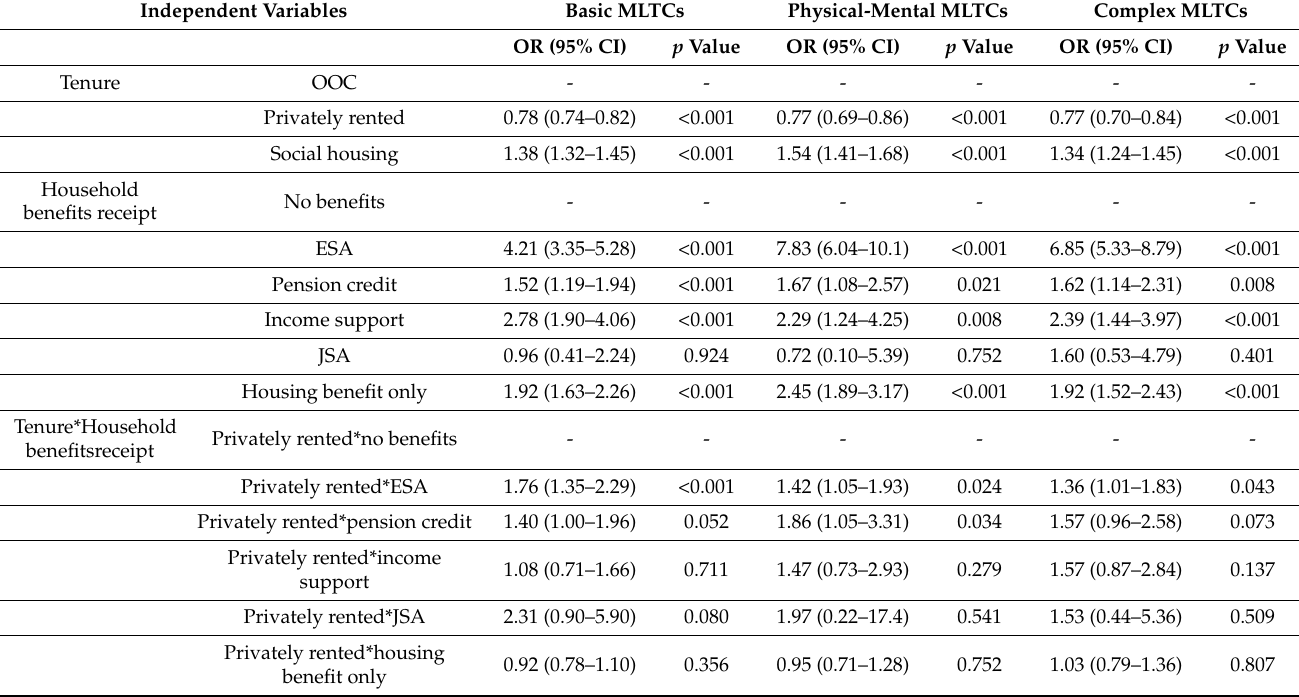
Table A4. Estimated odds ratios of basic, physical-mental, and complex MLTCs with household tenure when the final models tested for interactions between tenure and household benefits receipt for working-age adults residing in B&D in 2019/20 (N =